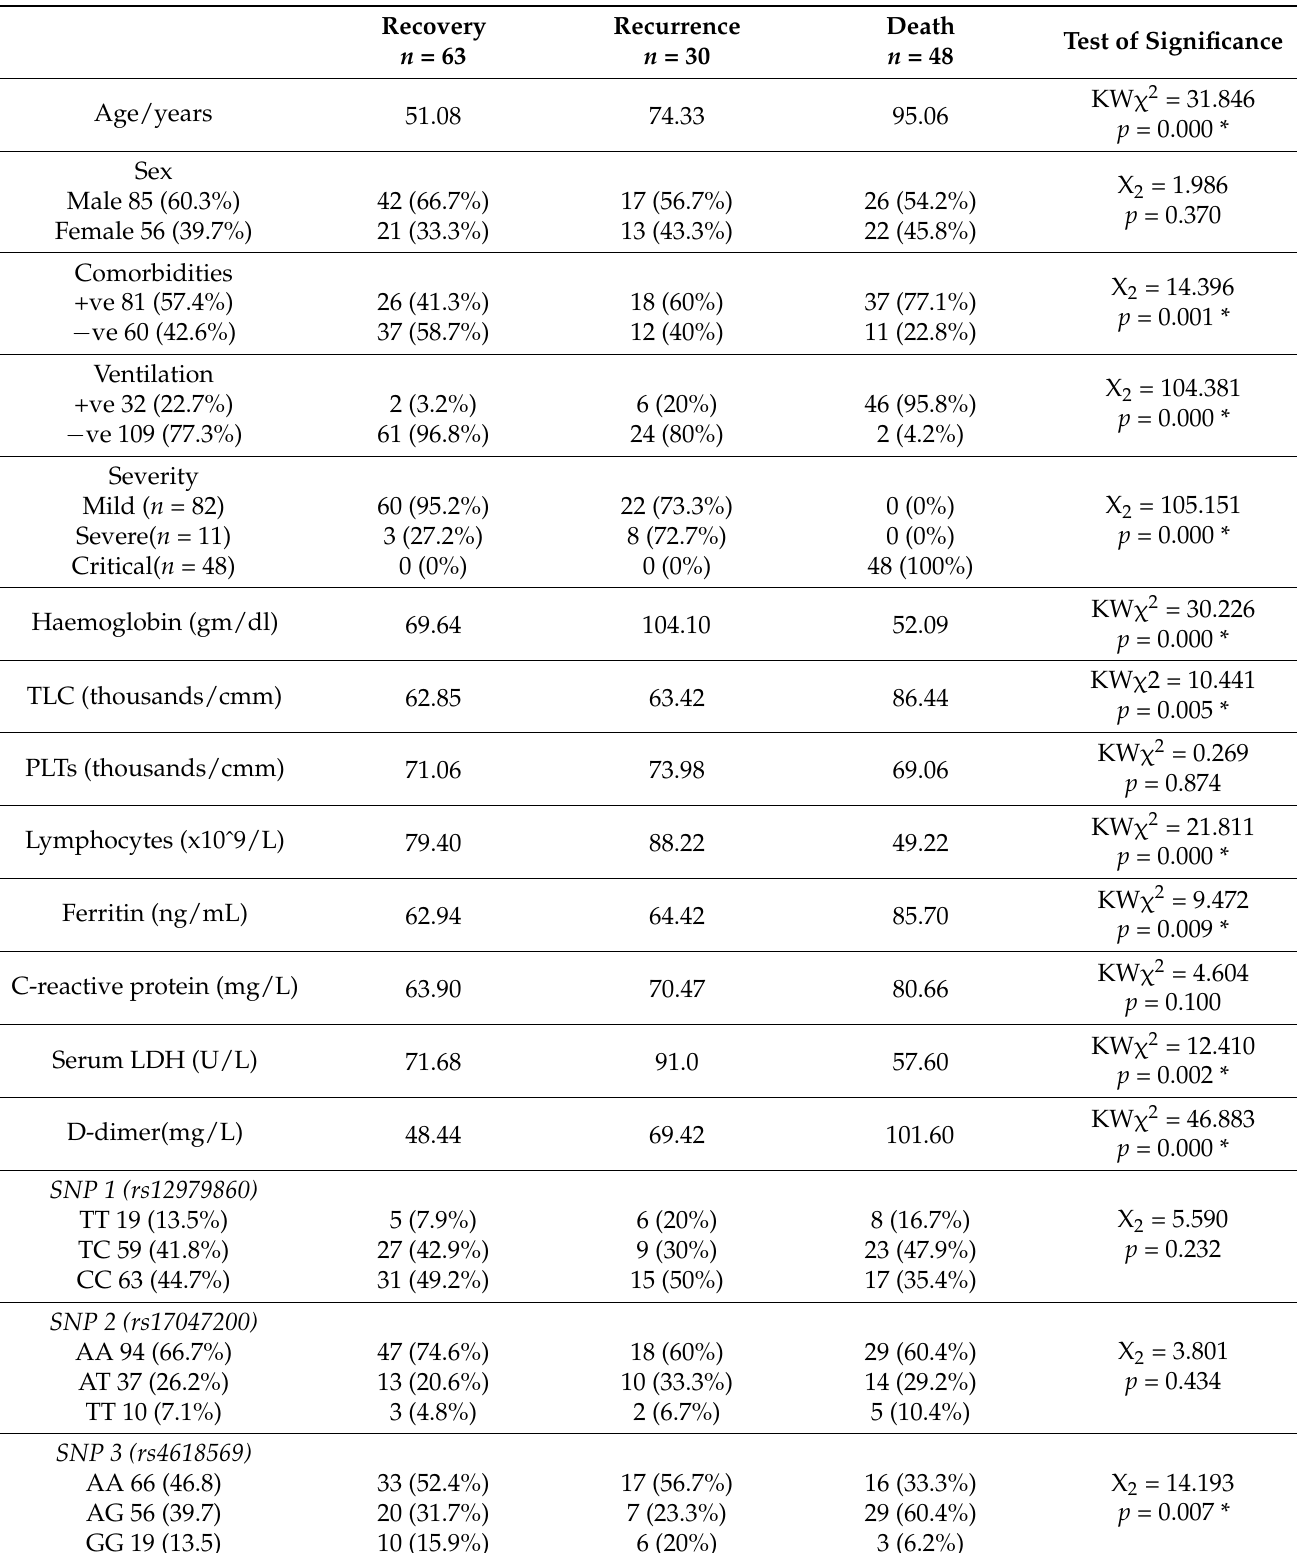
Table 3. Risk factors of death among studied cases